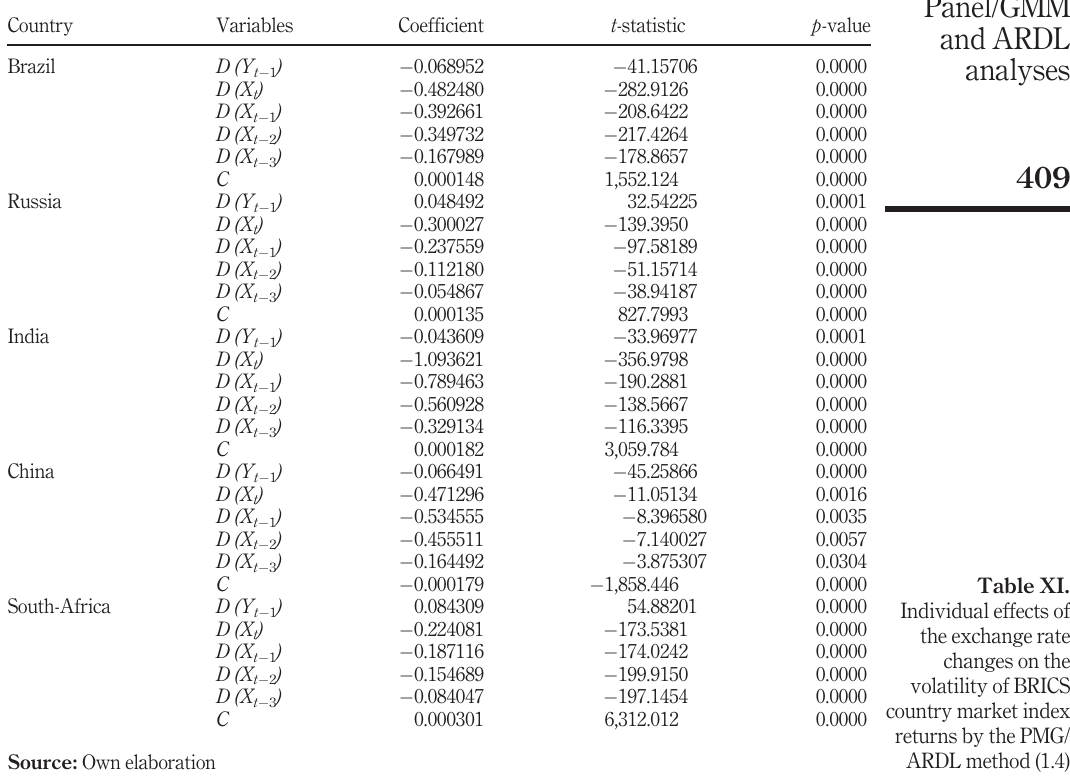
Table XI. Individual effects